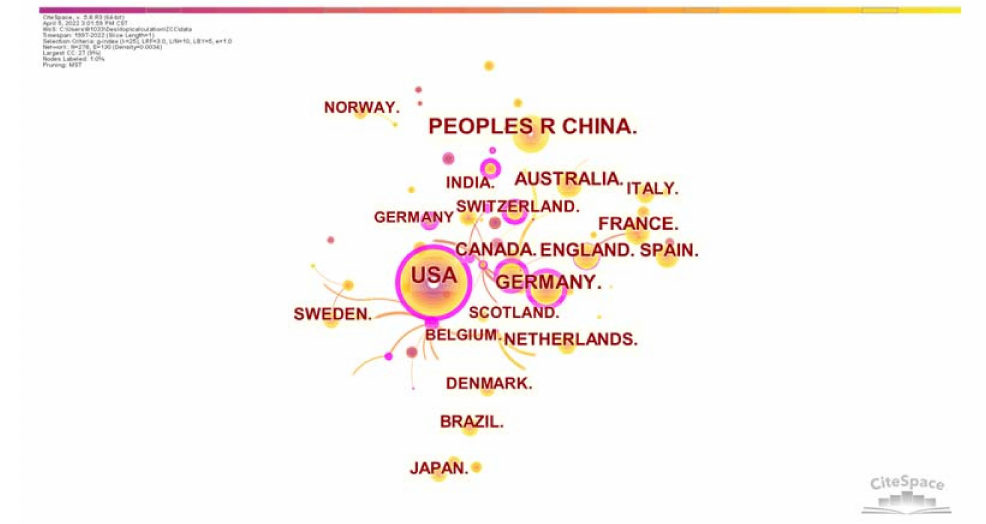
Figure 4. Knowledge map of cooperative countries in the research on the ZCC during